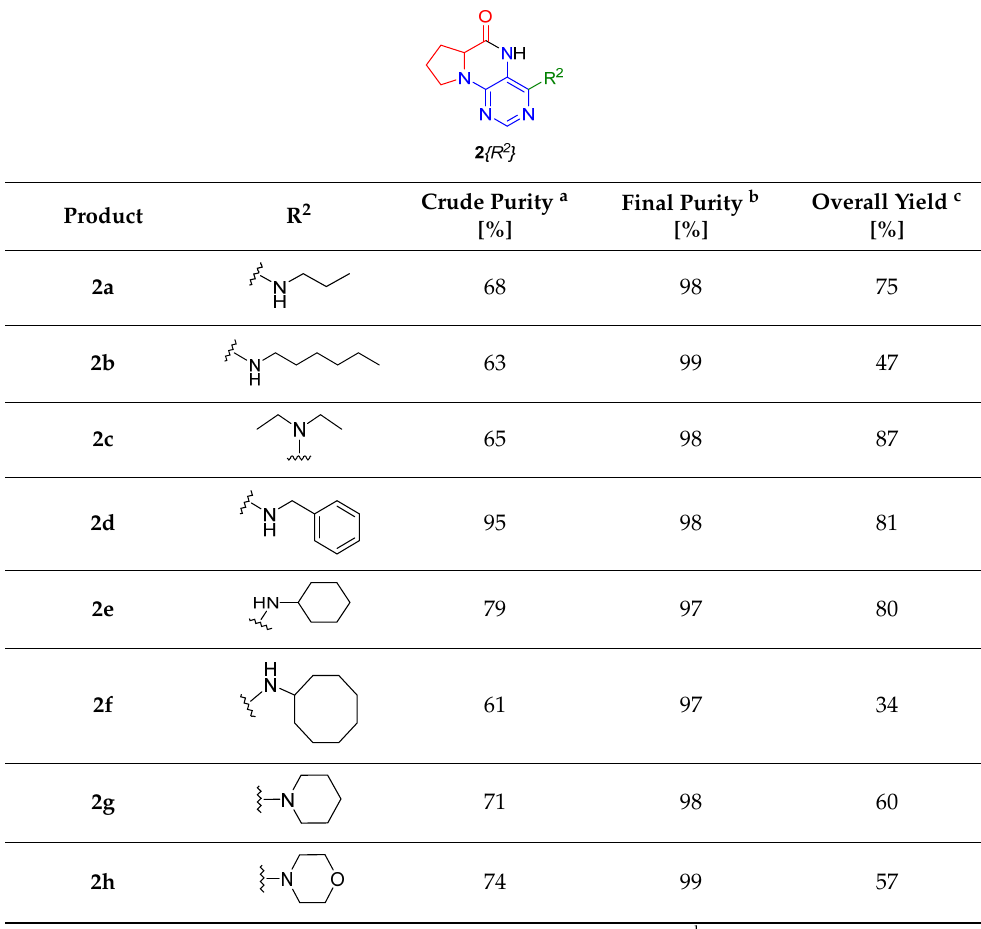
Table 2. Overview of synthesized tetrahydropyrrolopteridinones 2 .